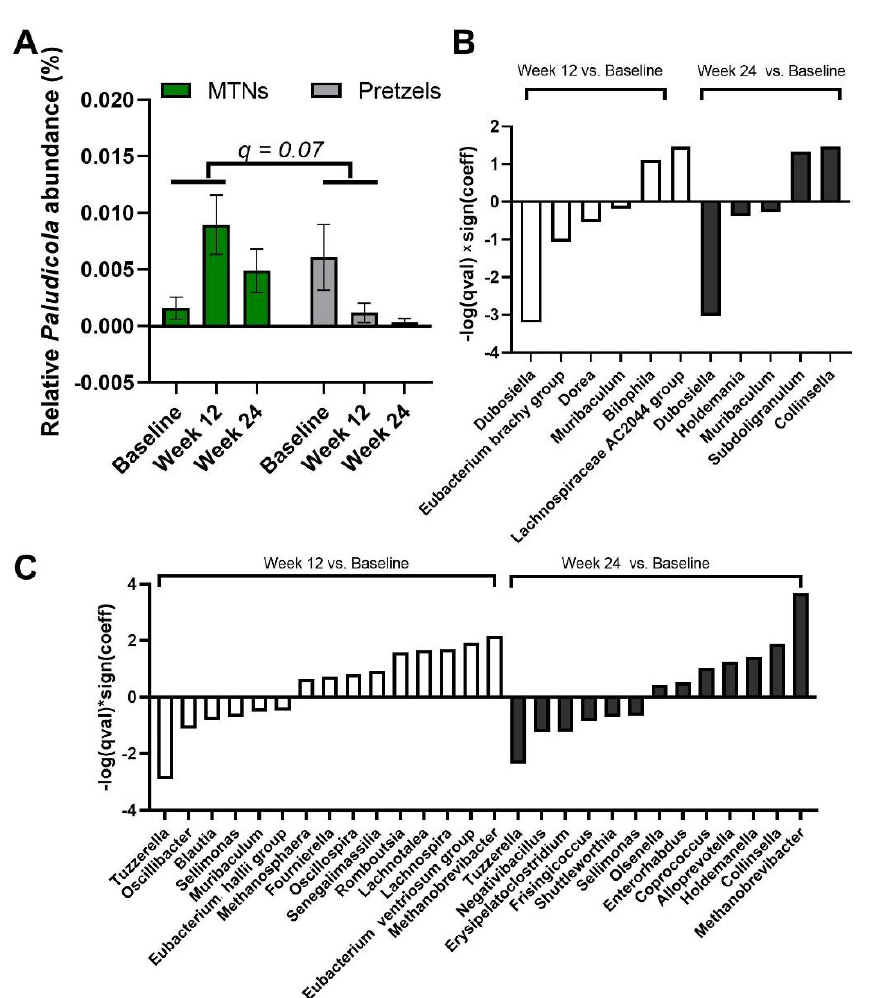
Figure 5. MaAsLin2 significant results at genus level. ( A ) Relative abundance of genus Paludicola at baseline, week 12, and 24. Significant association is observed between (interaction: week 12 and intervention) and relative abundance of Paludicola at the genus level. q value < 0.25 is considered significant. Significant association ( q < 0.25) between time and gut microbiome composition at genus level in ( B ) MTNs and ( C ) pretzel groups. Sign(coeff) refers to the absolute value of the coefficients in the MaAsLin2 model. − log( q value) × Sign(coeff) is calculated to emphasize associations with both large effects and high statistical significance.